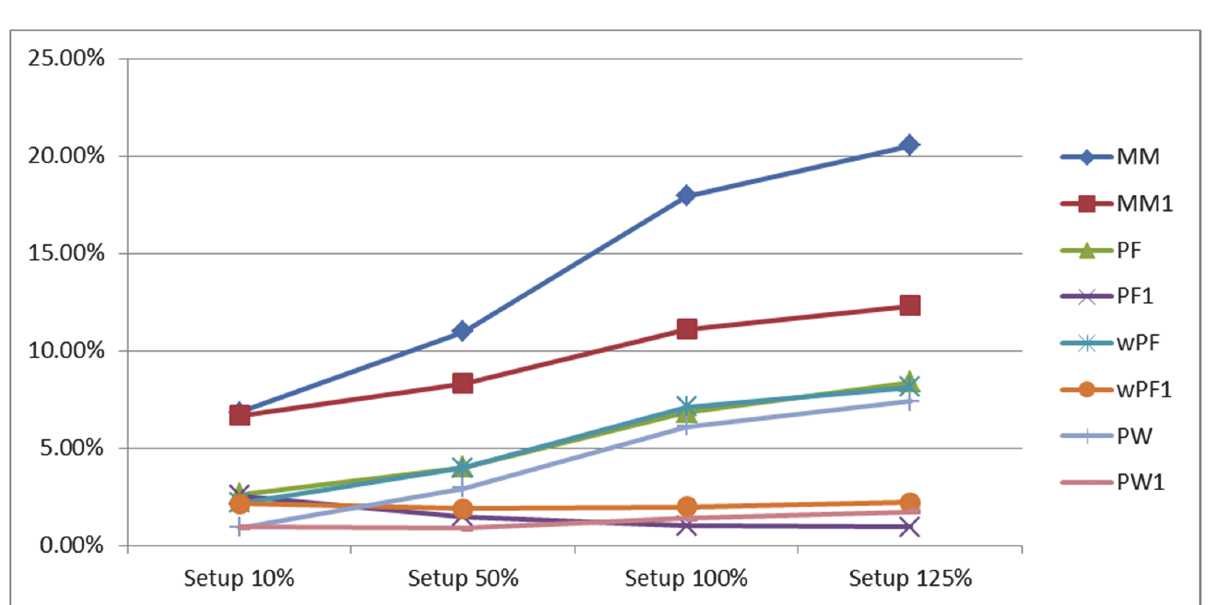
Fig. 2. MRD of the makespan of phase I